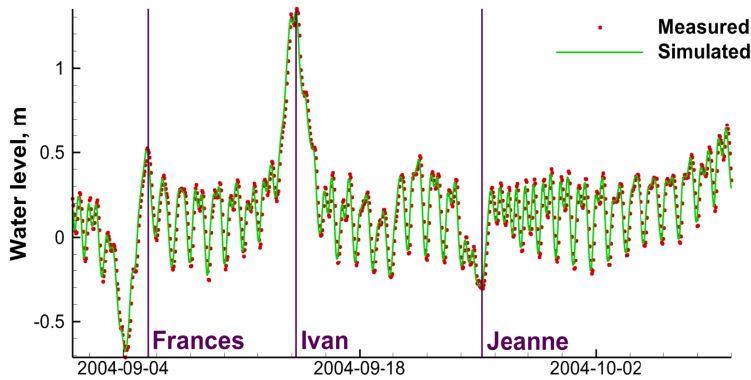
Figure 5. Water level before, during and after Hurricanes Frances, Ivan and Jeanne at Cat Point station.